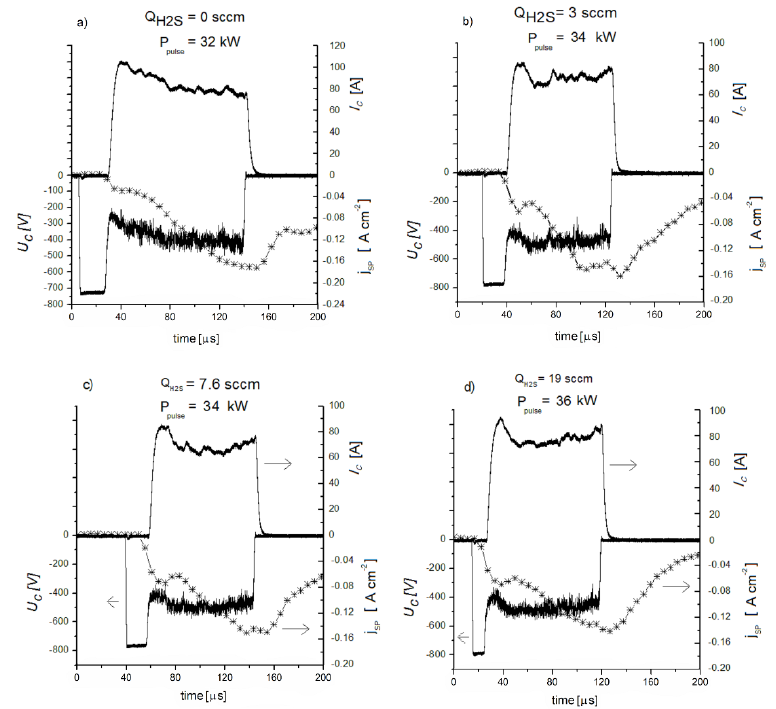
Figure 3. Discharge current and voltage waveforms for different values of mass flow rates of H 2 S, Q H2S , and time dependence of the pulse substrate ion flux density, j SP , ( a ) gas flow of H 2 S Q H2S = 0 sccm, ( b ) gas flow of H 2 S Q H2S = 3 sccm, ( c ) gas flow of H 2 S Q H2S = 7.6 sccm, ( d ) gas flow of H 2 S Q H2S = 19 sccm.